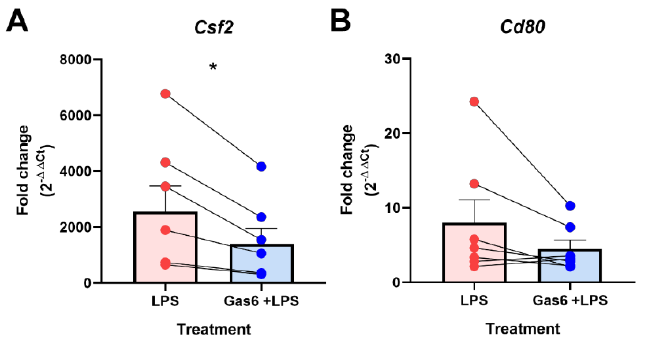
Figure 2. Gas6 inhibits the inflammatory LPS-induced upregulation of Csf2 mRNA in microglia. RT- qPCR was used to measure the fold change in gene expression of: ( A ) Csf2 and ( B ) Cd80 in microglial cultures in response to 8 h LPS (10 ng/mL) exposure in the presence or absence of Gas6 (1.6 µg/mL), which was added 1 h before. Data displayed is the fold change (2 −ΔΔCt ) normalised to non-stimulated cells (value of 1) with each pairwise change illustrated with a connected line for each separate culture and bars displaying mean ± SEM ( n = 6–7 independent experiments on separate cultures). Data was analysed by Wilcoxon signed-rank test; * p < 0 .05.